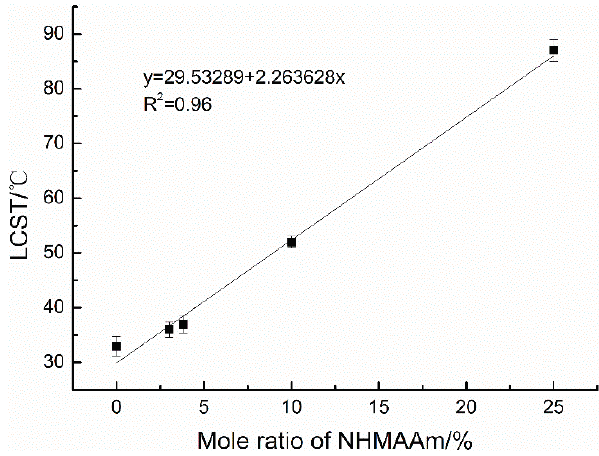
Figure 3. The lower critical solution temperature (LCST) of copolymer vs. the NHMAAm